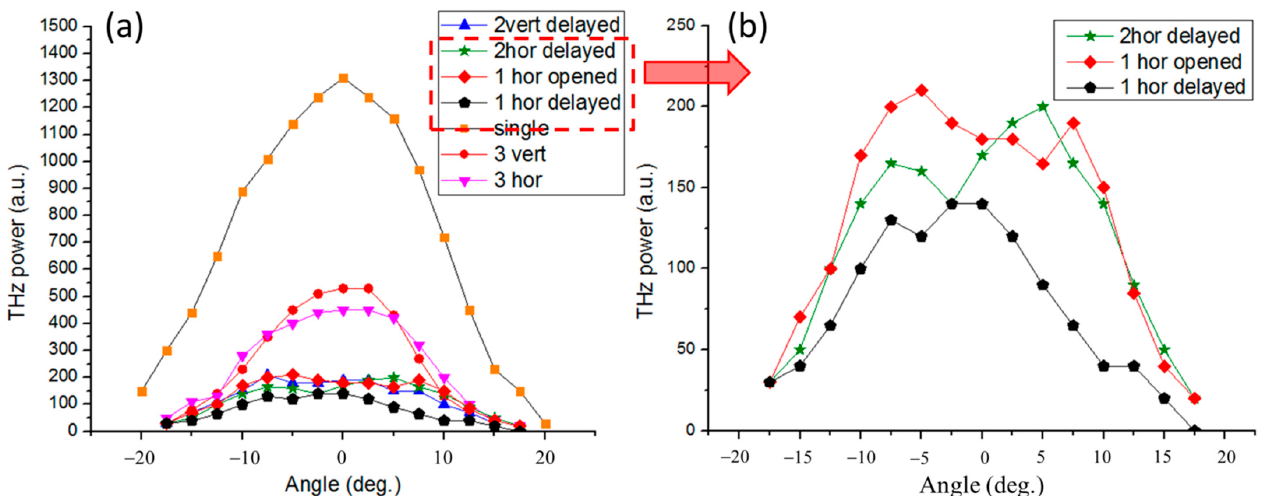
Figure 3. Angular distributions of THz power for different filament configurations. ( a ) Two vertically oriented filaments with mutual delay (blue triangle), 2 horizontally oriented filaments with mutual delay (green star), 1 filament without quartz plate (red rhombus), 1 filament with quartz plate (black pentagon), 1 filament without a mask (full laser beam) (orange circle), 3 vertically oriented filaments (red circle), 3 horizontally oriented filaments (purple circle); ( b ) Angular distribution for three selected cases.